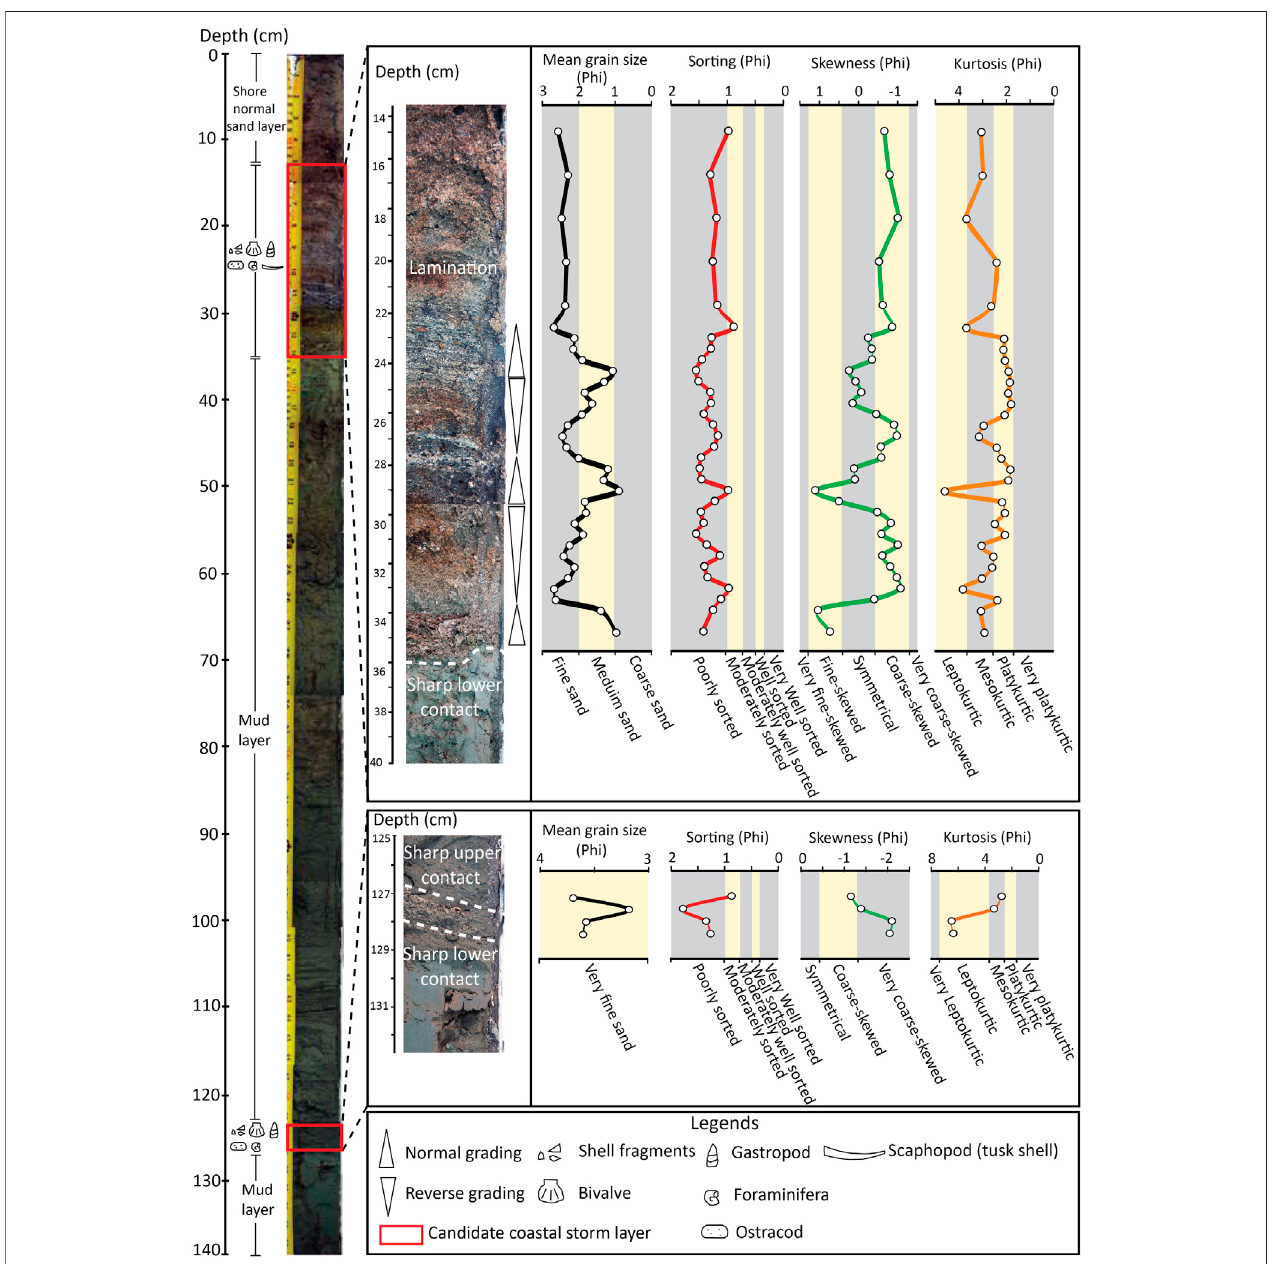
FIGURE4| Stratigraphy ofcore 1withthepositionofthesedimentarystructures observedin thecoretogether withthedistributionofthemean grainsize,sorting, skewness and kurtosis throughout the vertical pro fi le.